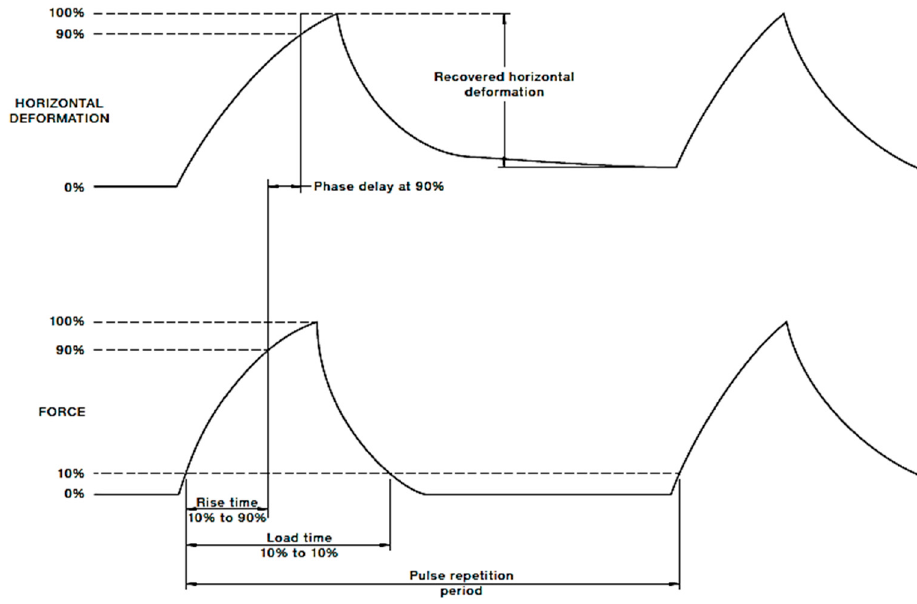
Figure 3. Load and horizontal deformation graph in Resilient Modulus Test.